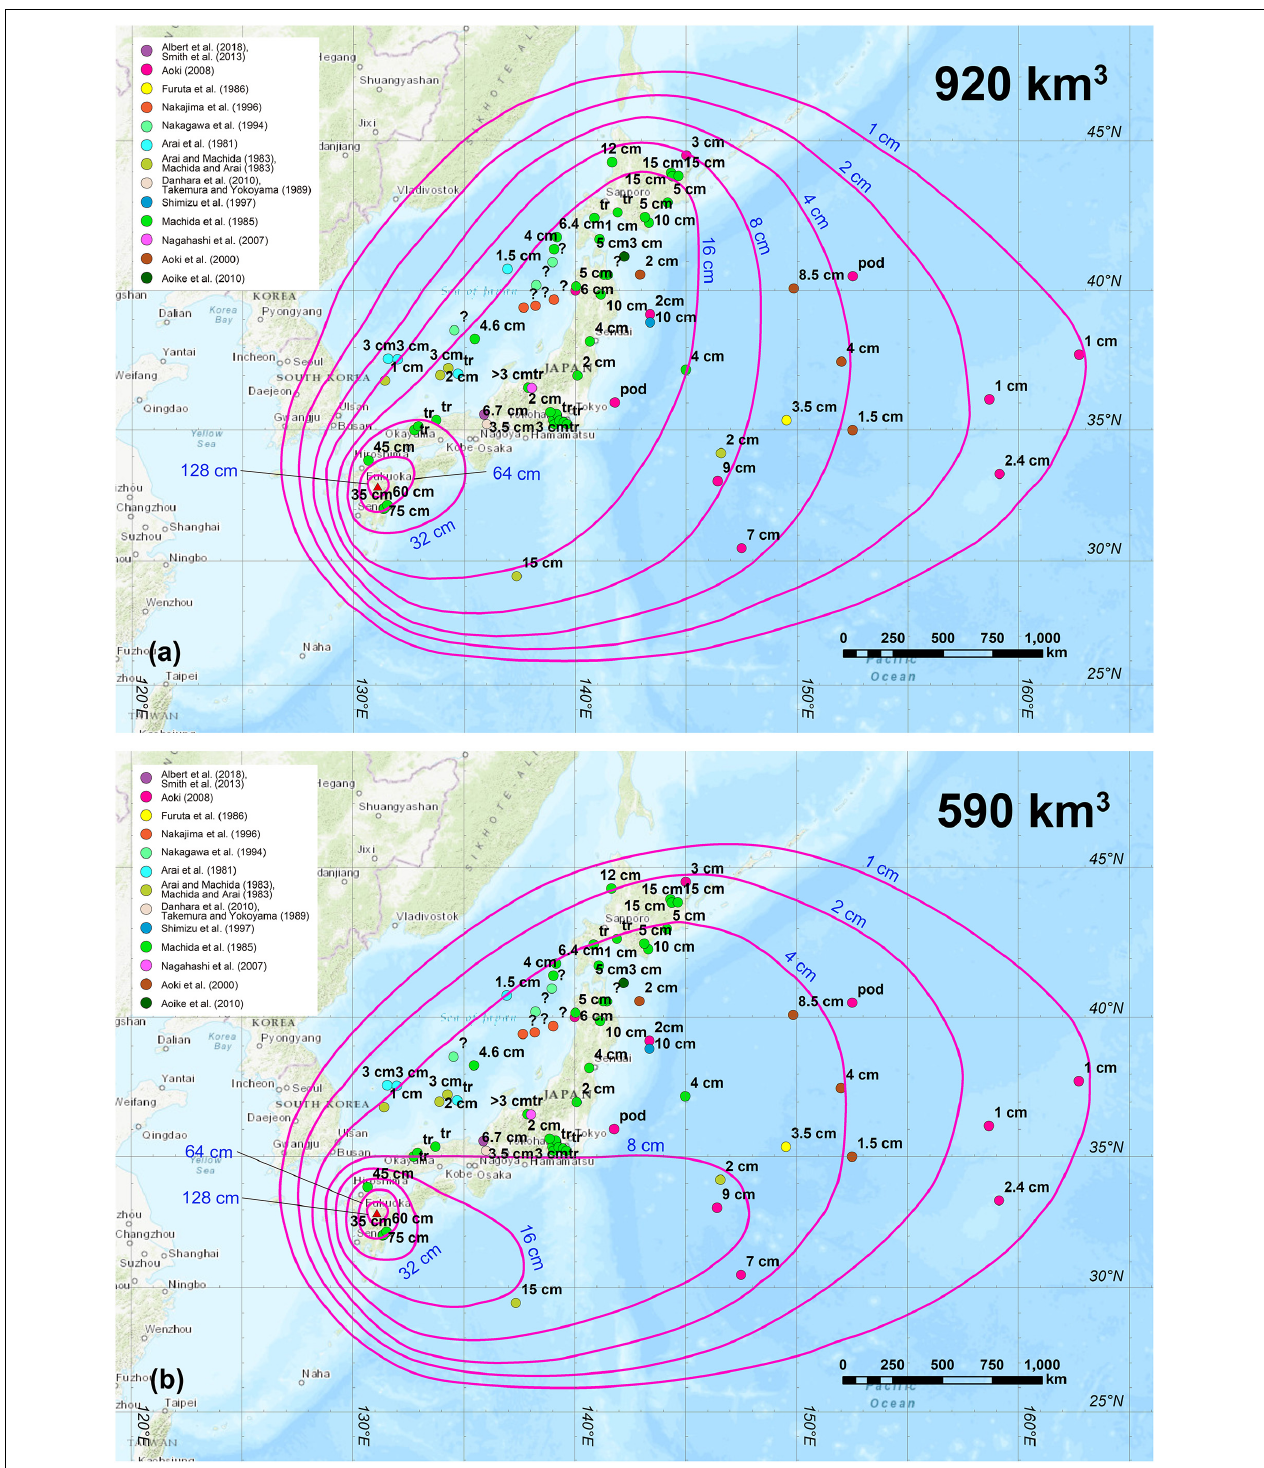
FIGURE 8 | Isopach maps of Aso-4 tephra fall distributions. Maximum case (a) and minimum case (b) . The data are tephra fall deposit from a borehole at Lake Suigetsu (Albert et al., 2018; Smith et al., 2013) (purple-colored circle), tephra fall deposit from a borehole at Lake Biwa (Takemura and Yokoyama, 1989; Danhara et al., 2010) (pale orange), submarine tephra deposits from Aoki (2008) (pink), Furuta et al. (1986) (yellow), Nakagawa et al. (1994) (light green), Nakajima et al. (1996) (orange), Arai et al. (1981) (light blue), Arai and Machida (1983) and Machida and Arai (1983) (greenish brown), Shimizu et al. (1997) (blue), Machida et al. (1985) (green), Aoki et al. (2000) (brown), and Aoike et al. (2010) (dark green), and on land tephra fall deposits from Machida et al. (1985) (green) and Nagahashi et al. (2007) (red purple).